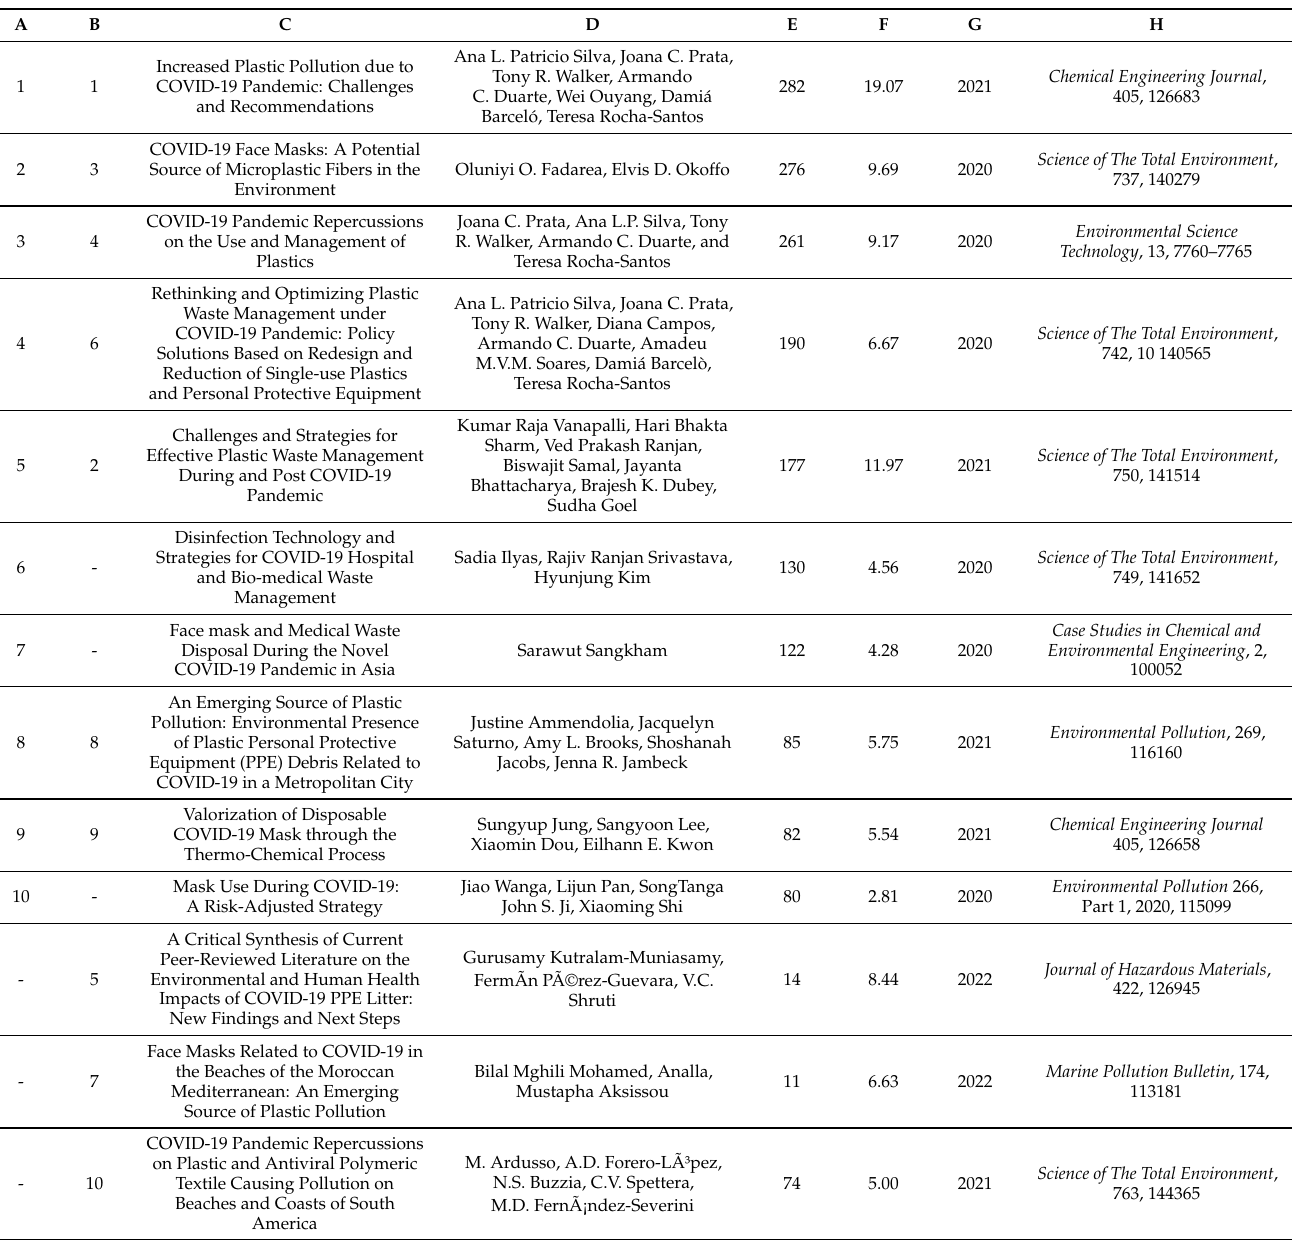
Table 4. List of most-relevant documents in the field in terms of total citations and normalized